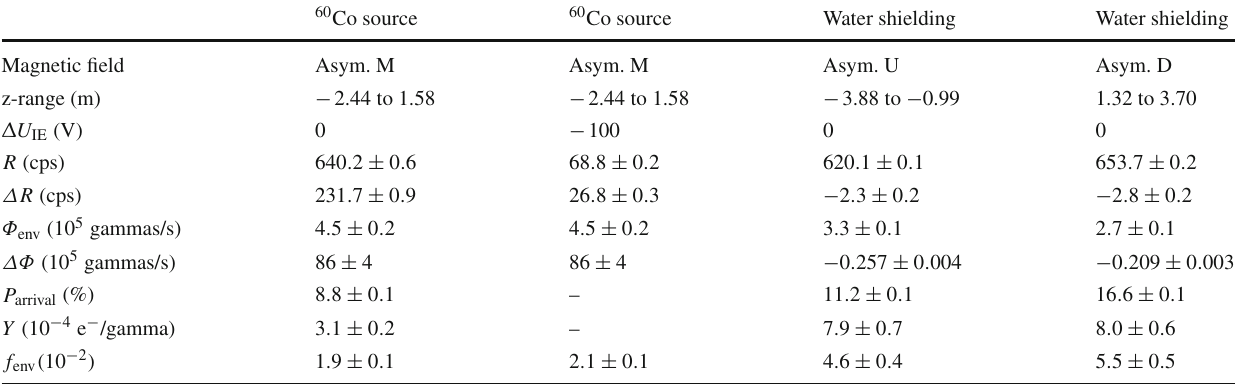
Table 7 Values used in the calculation of the secondary electron yield ( Y ) and fraction of secondaries induced by environmental gamma radi- ation ( f env ). See the text for details about each listed parameter. Φ env and ΔΦ differ for each asymmetric field setting (since different regions